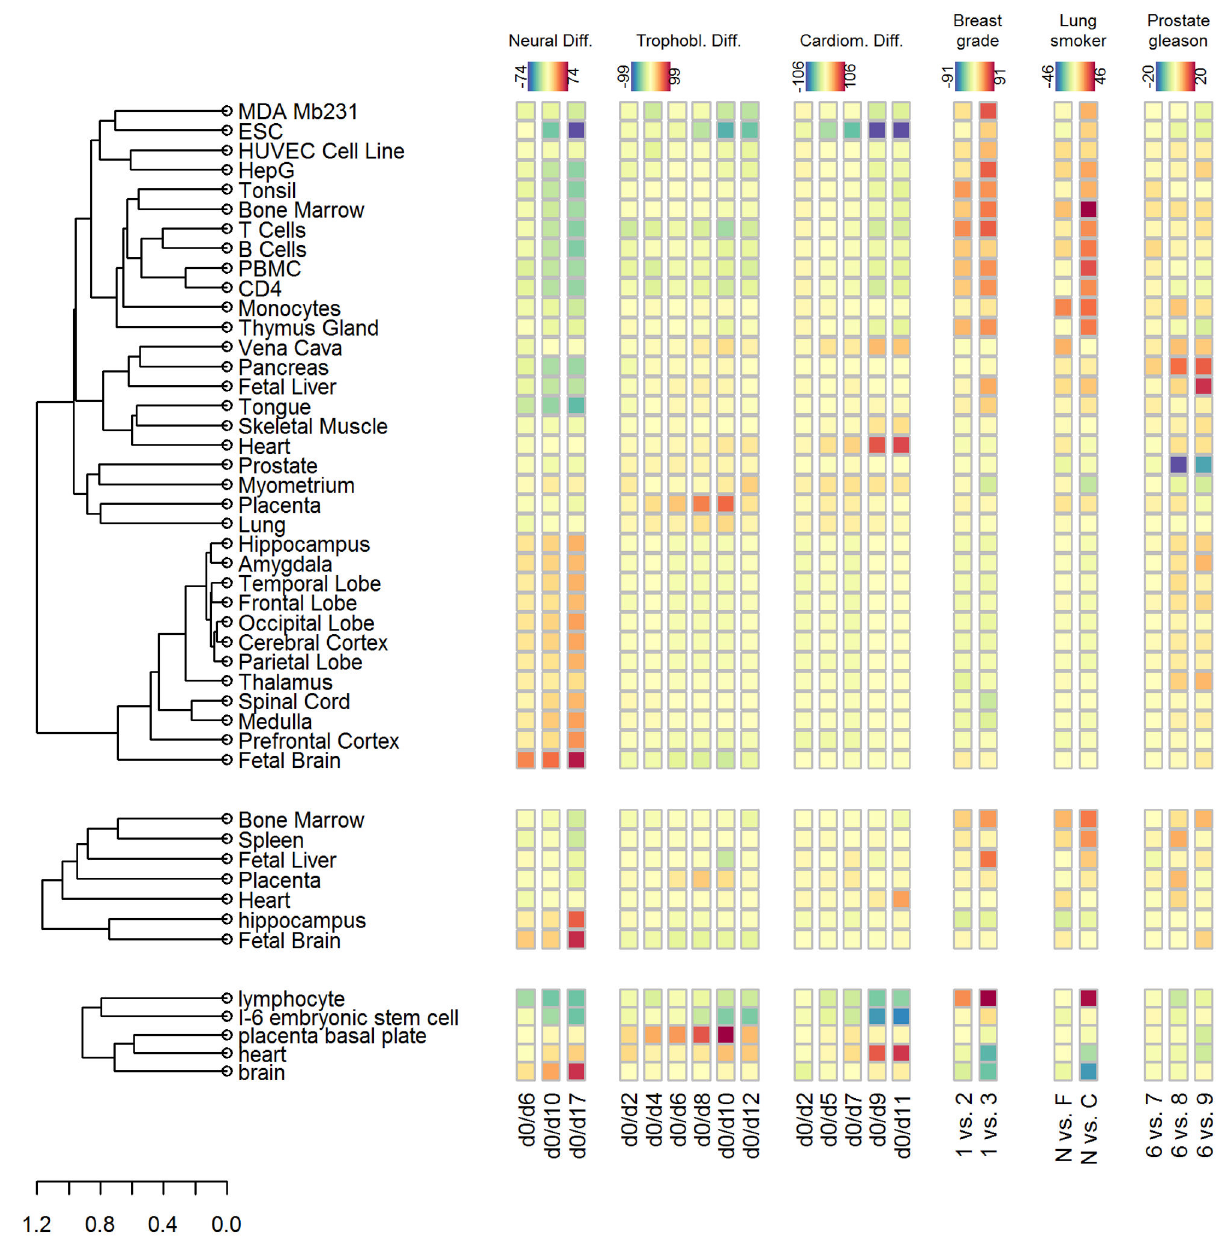
Figure 5. Heatmap of PhysioScores combining selected signatures from three PhysioSpaces. The PhysioScores for all six investigated datasets are visualized in context for selected signatures. In order to evaluate the stability of the method, the signatures were derived from three different physiological databases resulting in PhysioSpaces 1-3. The results are depicted in a heatmap-like representation. The color scheme differs between datasets but is the same for the PhysioSpaces 1-3, ranging from negative values in blue and green to positive values in orange and red. The dendrogram represents a hierarchical clustering of the signatures according to a Pearson-correlation distance. Values within clusters are usually similar, e.g clusters of neural or immune signatures. The results corresponding to PhysioSpaces 1-3 show similar dynamics and consistent dominating signatures, while the absolute values are only approximately